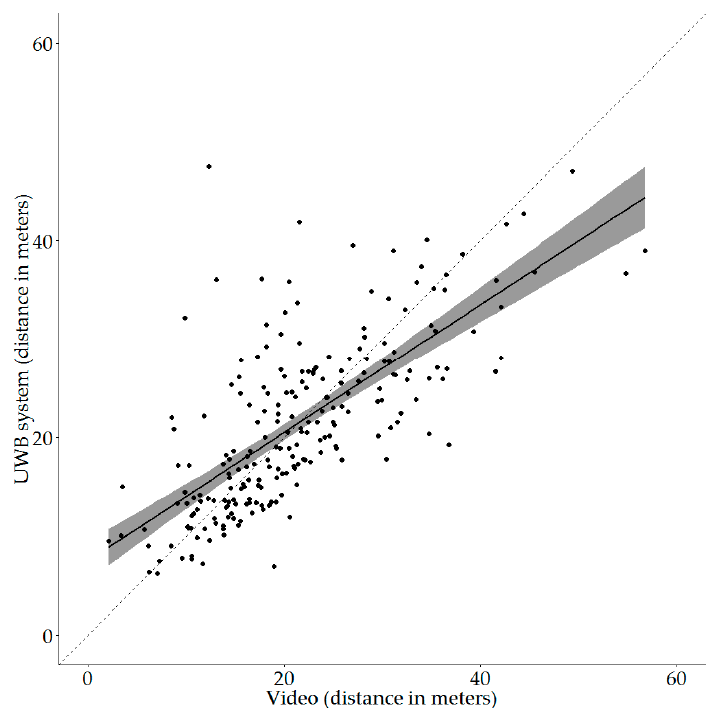
Figure 1. Plot of the correlation between the distances recorded from video observations using Kinovea and the distances recorded with the ultra-wideband (UWB) system. Dots represent individual data points. The solid black line shows the correlation coefficient, with the grey area representing the 95% confidence interval. The dashed line shows the diagonal where UWB and video distances would be exactly the same.